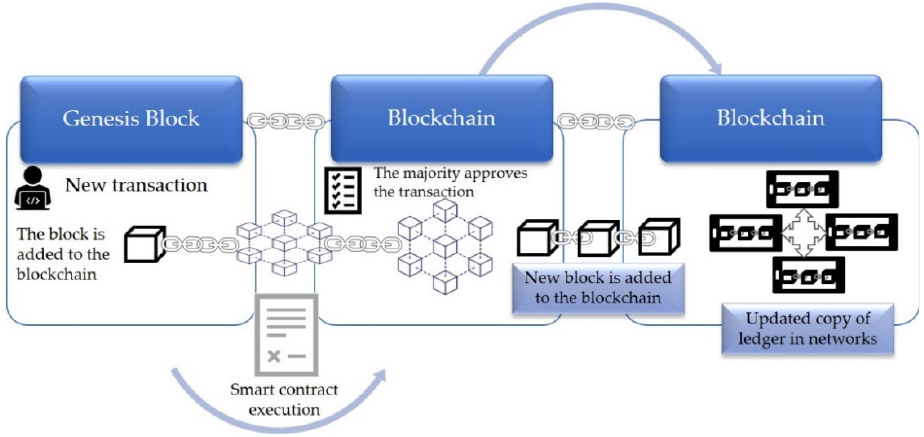
Figure 1. Basic steps in blockchains.